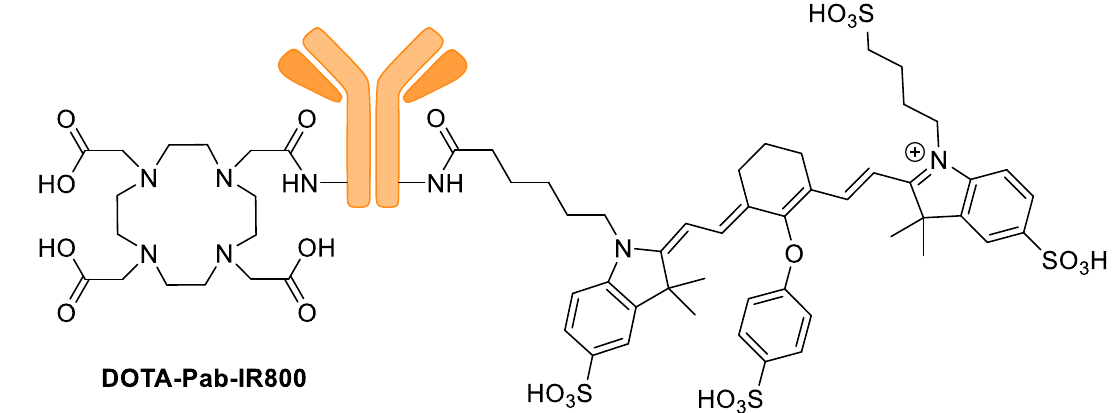
Figure 13. Structure of DOTA-Pab-IR800 .